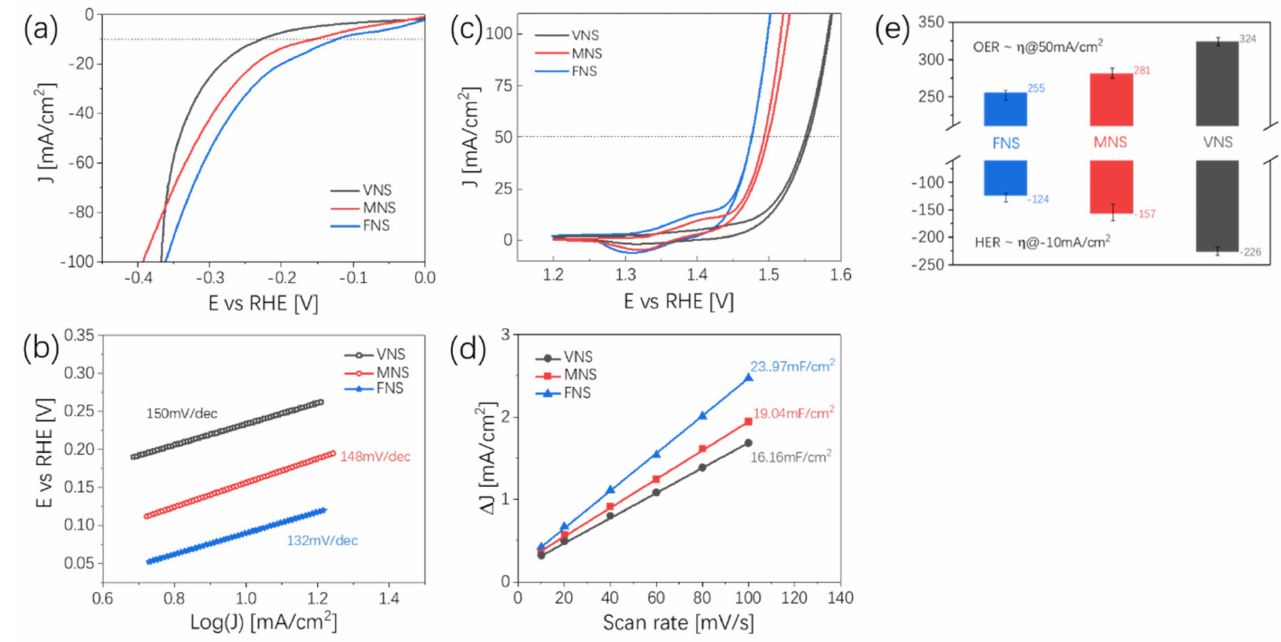
Figure 6. Electrochemical performance of MNi x Se y (M = V, Mn and Fe). ( a ) LSV curves of samples in HER; ( b ) Tafel slope results of HER; ( c ) CV curves of samples in OER; ( d ) C dl values and relative electrochemical active surface areas in the OER process; ( e ) comparison of HER (overpotential @ 10mA/cm 2 ) and OER activities (overpotential @ 50 mA/cm 2